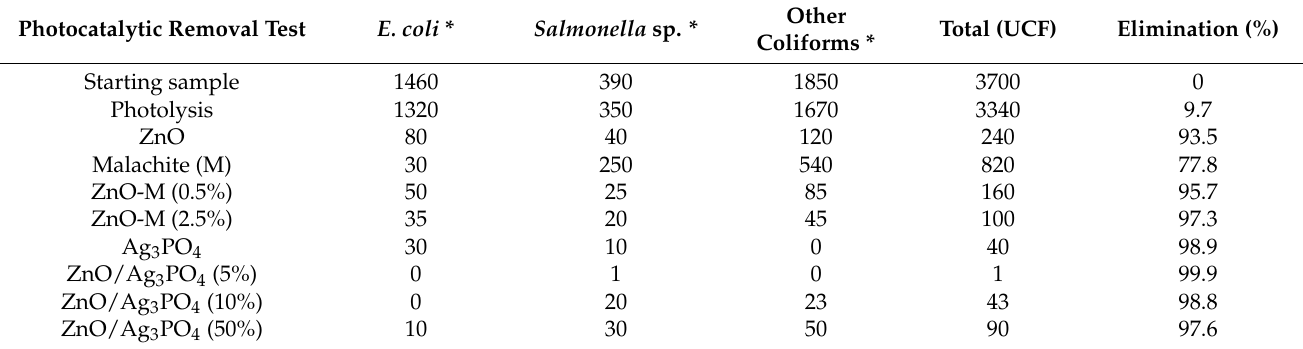
Table 4. Enteropathogenic bacteria removal from samples of handmade textile staining wastewater.